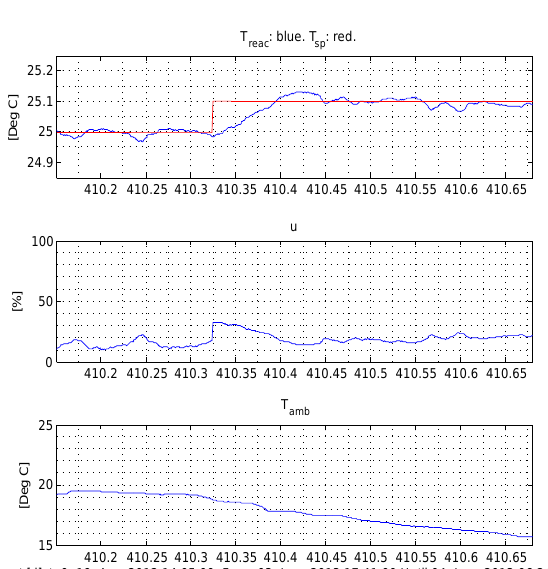
Figure 10: Real responses in the temperature control system with enhanced R-ZN PI settings with k r = 4